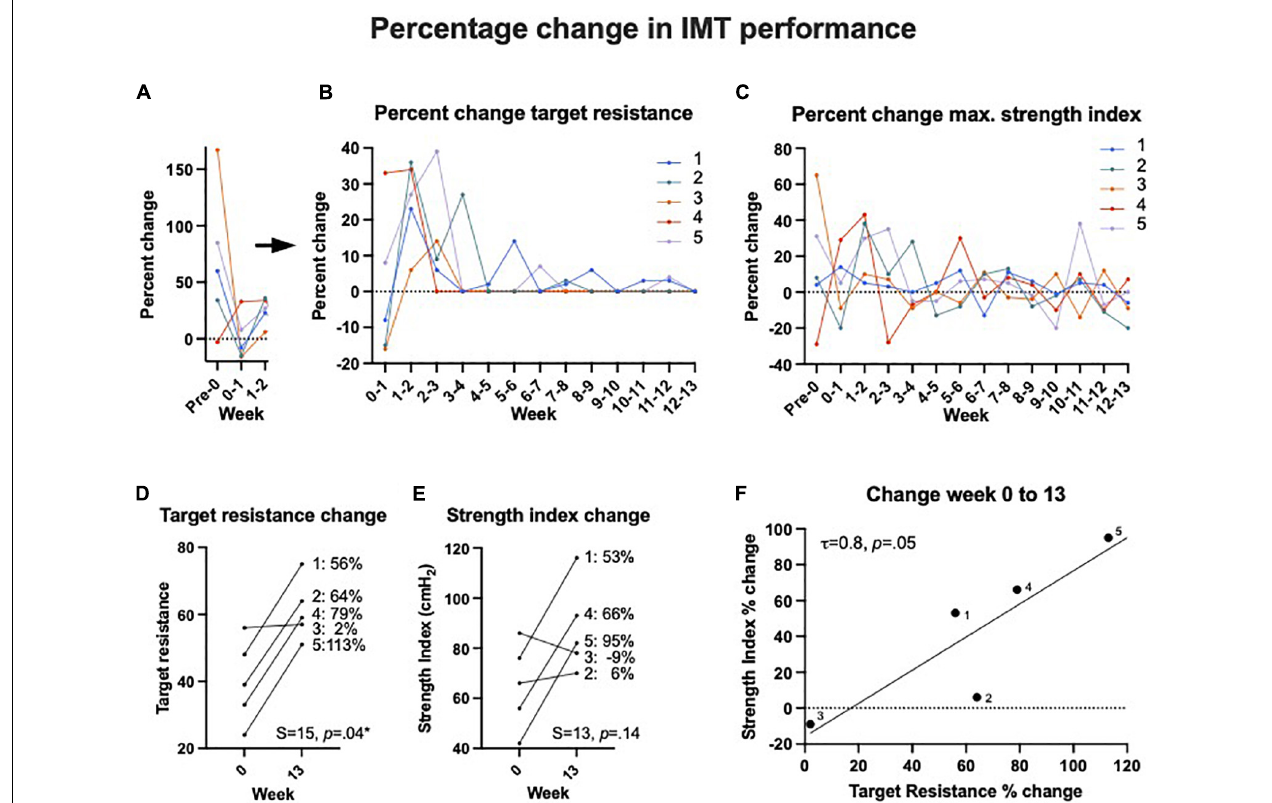
FIGURE 4 | Inspiratory muscle training (IMT) effects on device performance in percentage change. Panels (A,B) show the percent change in target resistance measured in cmH 2 O from 1 week to the next. For better visualization and due to the large drop from the first attempt until the end of the practice week (week 0), panel (A) shows the data points at a different y -axis scale separately from panel (B) the following weeks. After 8–9 weeks, there was little to no change in target resistance, i.e., participants were unable to increase their inspiratory strength further at that point. Note that this was not the case for participant 1, whose performance was superior to the other 4. (C) The percent change of maximum strength index from 1 week to the next showed greater overall variability but except individual peaks, the general trend evened on the lower end after 4–5 weeks. (D) The overall percentage of change in target resistance (measured in cmH 2 O) and (E) maximum strength index from week 0 to week 13. (F) There was a significant association between target resistance and strength index change in percent from week 0 to week 13 as one would